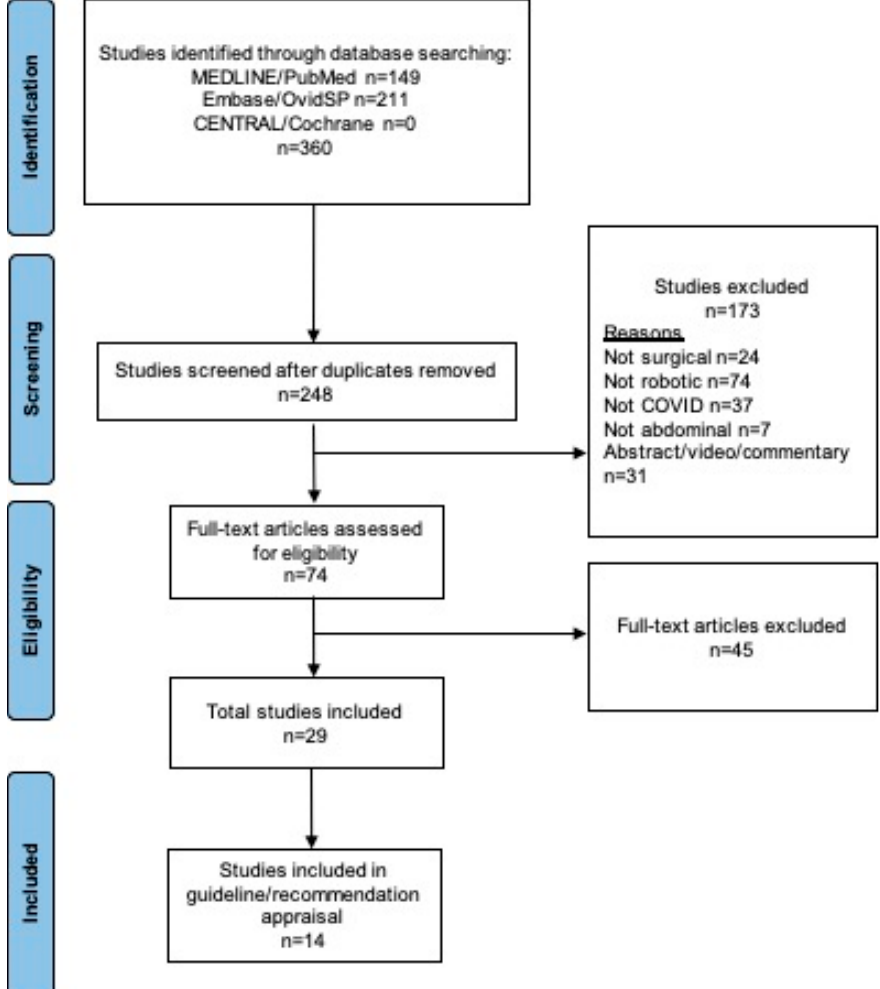
Figure 1. PRISMA flowchart of study assessment, exclusion (including reasons), and inclusion.